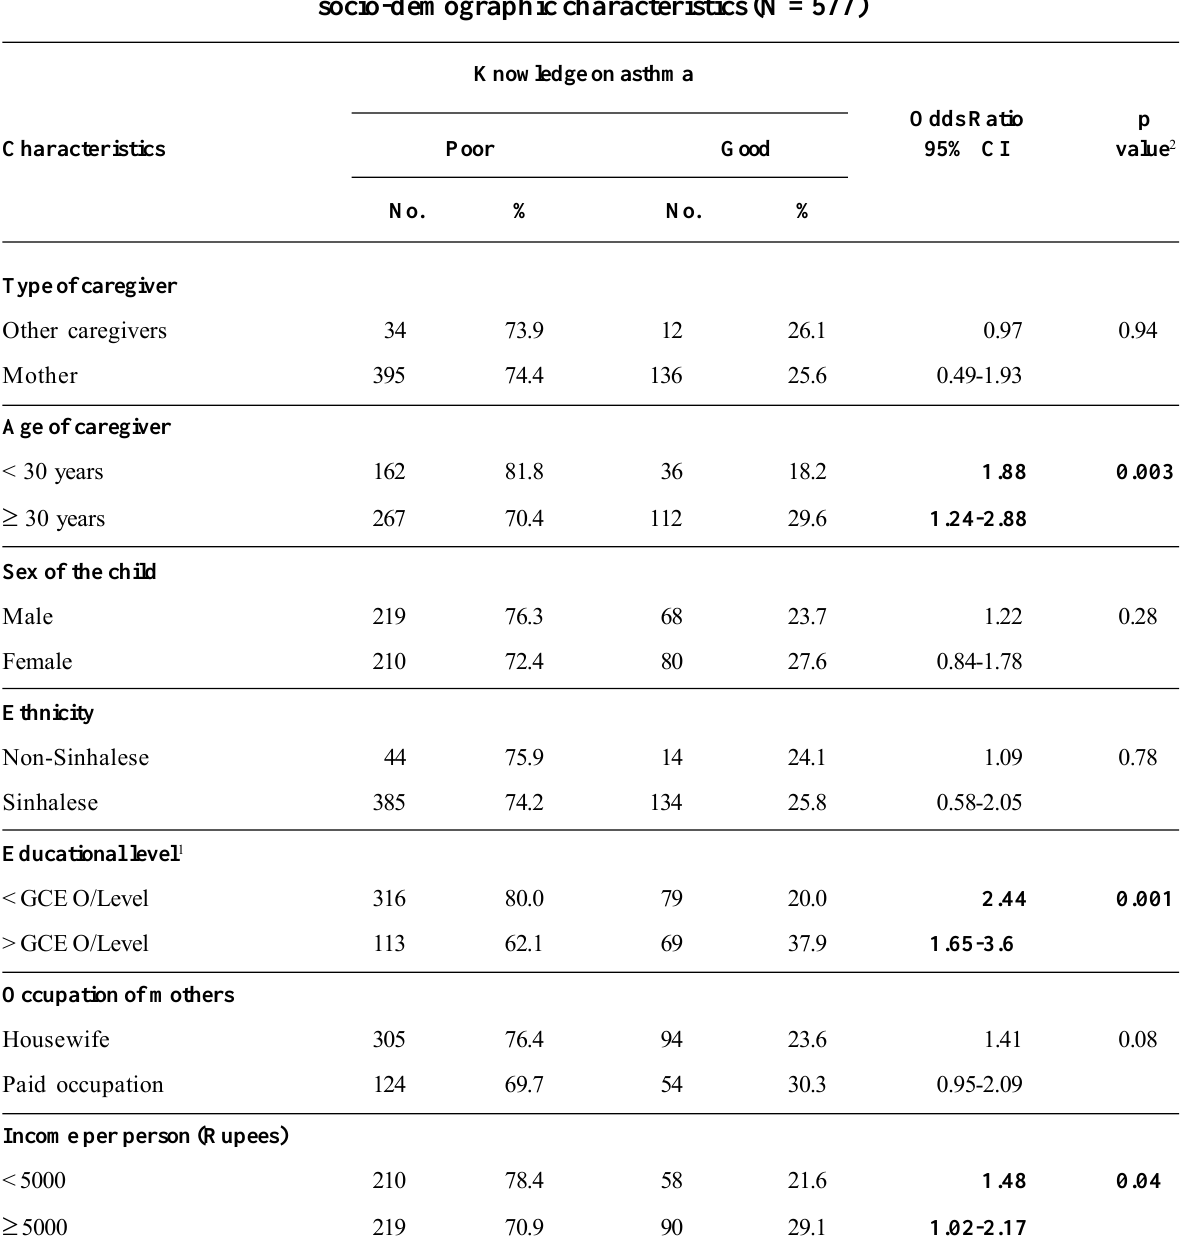
Table 3. Association of the caregivers’ knowledge on asthma with their socio-demographic characteristics (N =